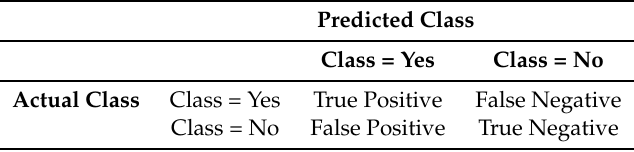
Table 2. The possible results of the classification prediction.